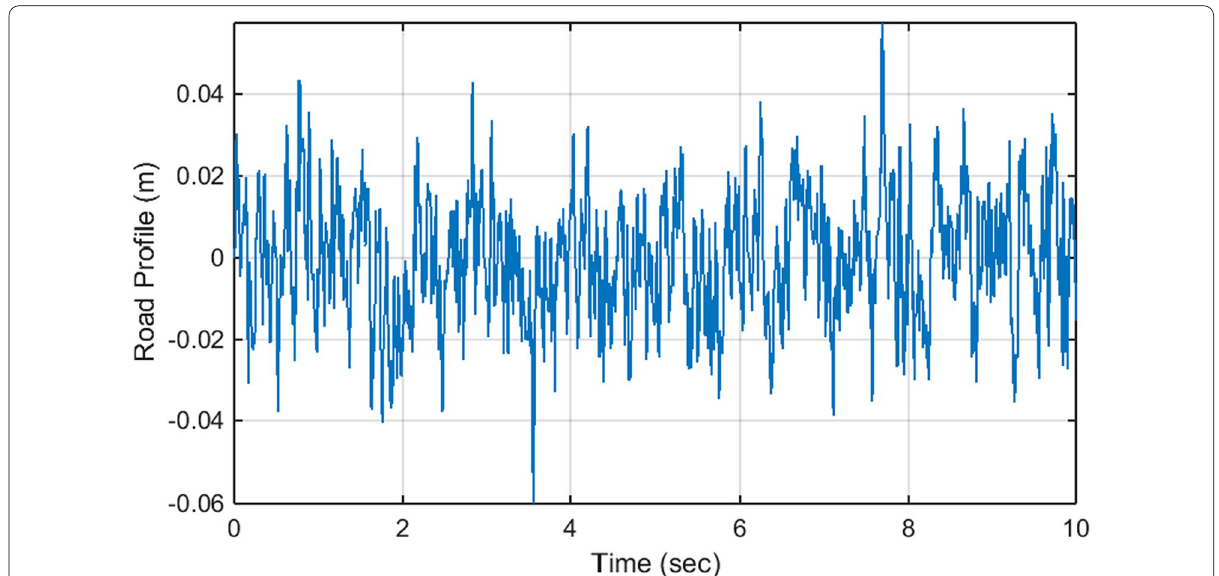
Fig. 6 Road surface (Class C, velocity 80 kmph)